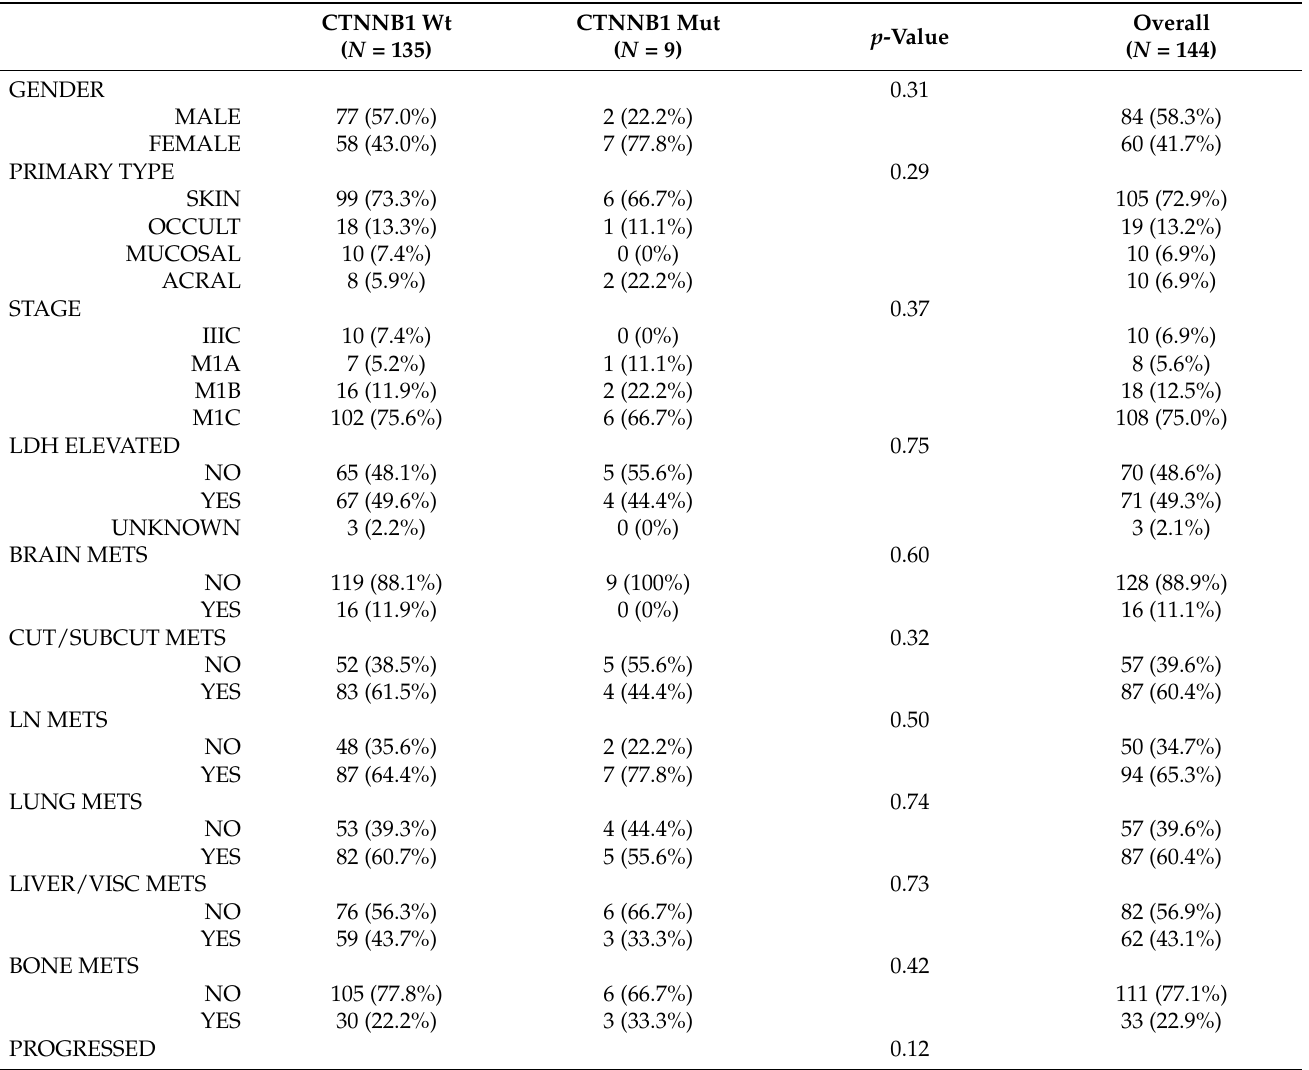
Table 4. Clinical and transcriptomic characteristics of anti-PD-1 monotherapy treated melanoma patients from